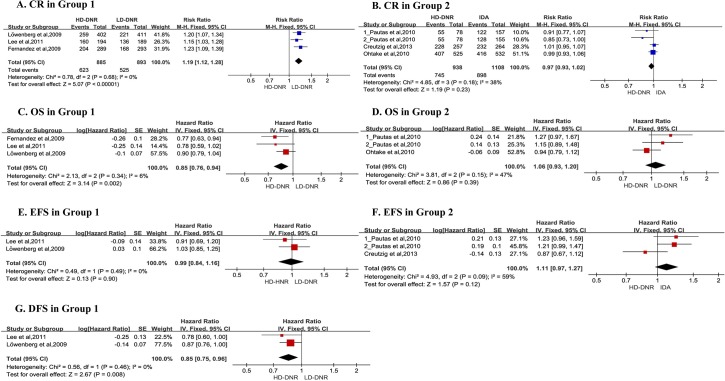
Forest plots of the RR/HR for CR, OS, EFS, DFS in Group 1 and Group 2.SE, standard error;Fixed, fixed-effect model; CI, confidence interval. Pooled RRs and HRs were computed using fixed-effect models. The size of the squares reflects each study’s relative weight, andhorizontal lines through the squares represent 95% CIs. the diamond represents the aggregate RR/HR and 95%CIs. A. CR in Group 1 Group 1, high doses of daunorubicin vs. low doses of daunorubicin; HD-DNR, high doses of daunorubicin; LD-DNR, low doses of daunorubicin; CR, complete remission. B. CR in Group 2 Group 2, high doses of daunorubicin vs. idarubicin; HD-DNR, high doses of daunorubicin; IDA, idarubicin; CR, complete remission. There were two subgroups named 1_Pautas et al, 2010 and2_ Pautas et al, 2010 devided from the same literature. The first one corresponded to 80×3 mg/m² of daunorubicin vs. 12×3 mg/m² of idarubicin and the second one corresponded to 80×3 mg/m² of daunorubicin vs. 12×4 mg/m² of idarubicin. C. OS in Group 1 Group 1, high doses of daunorubicin vs. low doses of daunorubicin; HD-DNR, high doses of daunorubicin; LD-DNR, low doses of daunorubicin; OS, overall survival. D. OS in Group 2 Group 2, high doses of daunorubicin vs. idarubicin; HD-DNR, high doses of daunorubicin; IDA, idarubicin; OS, overall survival. There were two subgroups named 1_Pautas et al, 2010 and2_ Pautas et al, 2010 devided from the same literature. The first one corresponded to 80×3 mg/m² of daunorubicin vs. 12×3 mg/m² of idarubicin and the second one corresponded to 80×3 mg/m² of daunorubicin vs. 12×4 mg/m² of idarubicin. E. EFS in Group 1 Group 1, high doses of daunorubicin vs. low doses of daunorubicin; HD-DNR, high doses of daunorubicin; LD-DNR, low doses of daunorubicin; EFS, event-free survival. F. EFS in Group 2 Group 2, high doses of daunorubicin vs. idarubicin; HD-DNR, high doses of daunorubicin; IDA, idarubicin; EFS, event-free survival. There were two subgroups named 1_Pautas et al, 2010 and2_ Pautas et al, 2010 devided from the same literature. The first one corresponded to 80×3 mg/m² of daunorubicin vs. 12×3 mg/m² of idarubicin and the second one corresponded to 80×3 mg/m² of daunorubicin vs. 12×4 mg/m² of idarubicin. G. DFS in Group 1 Group 1, high doses of daunorubicin vs. low doses of daunorubicin; HD-DNR, high doses of daunorubicin; LD-DNR, low doses of daunorubicin; DFS, disease-free survival.